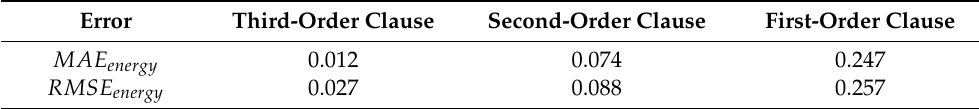
Table 8. Average individual k -order logic clause and energy error linear fit coefficients. Error